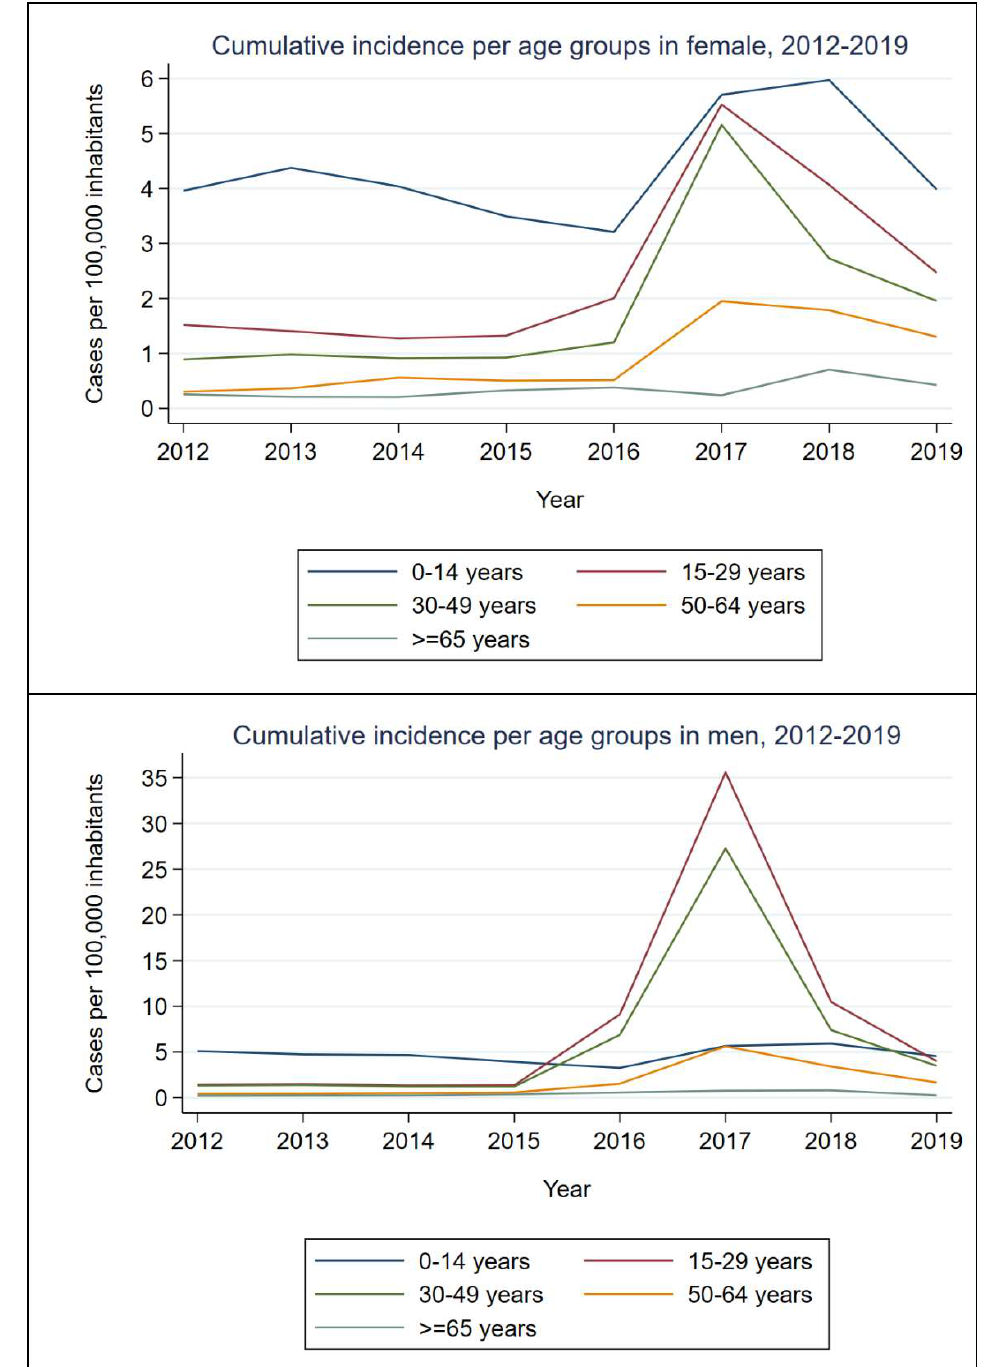
Figure 4. Cumulative incidence by sex and age groups, 2012–2019.